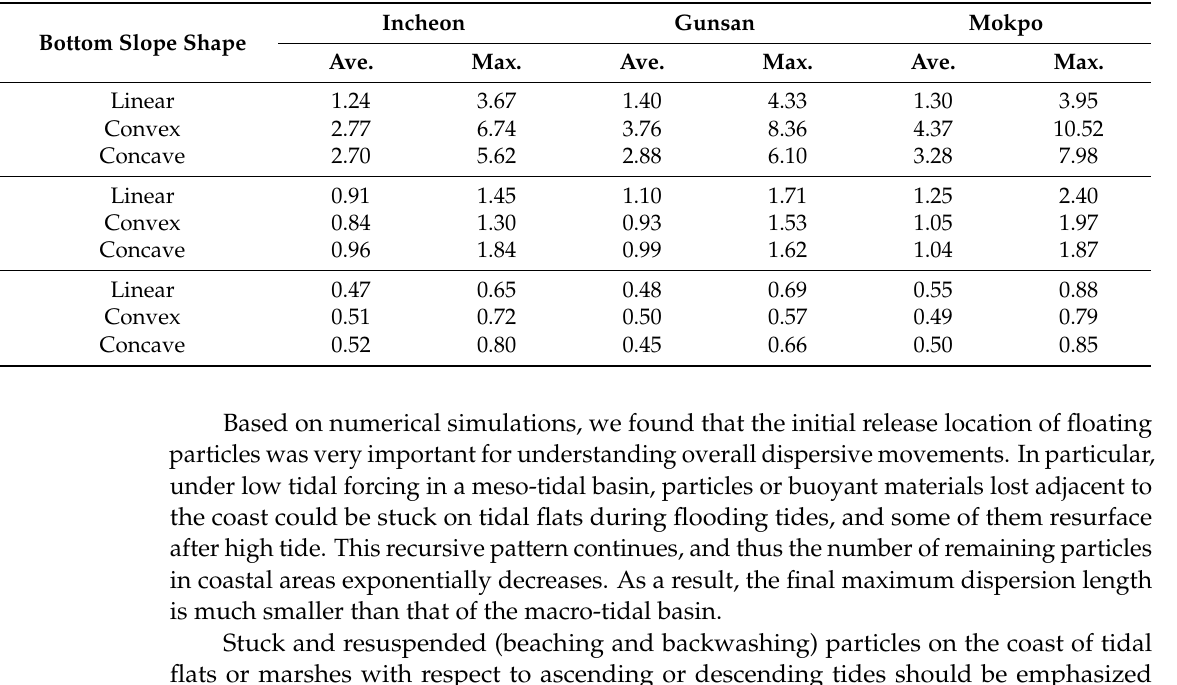
Figure 6. Temporal variation of fluctuating particle movement with respect to bottom shapes: linear, concave, and convex for macro- (Incheon) to meso-tidal (Mokpo) conditions. Table 2. Average and maximum dispersion distance (km) in macro-tidal and meso-tidal environments according to the bottom slope